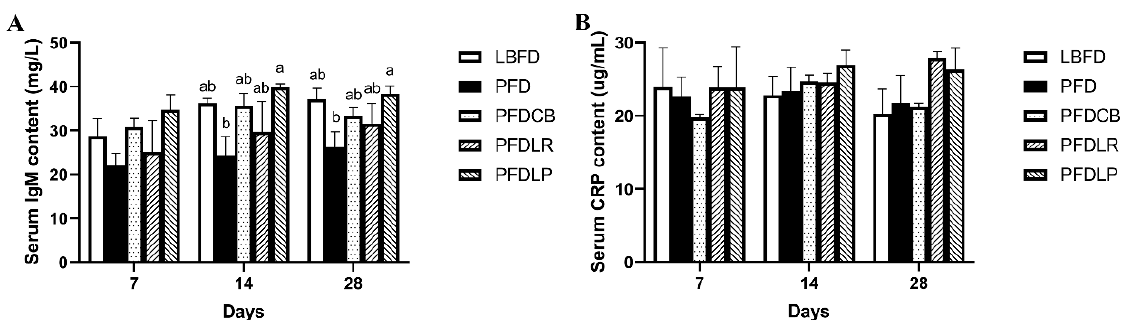
Figure 4. Serum content of IgM ( A ) and CRP ( B ) of mandarin fish in different feeding groups (LBFD, PFD, PFDCB, PFDLR and PFDLP) at day 7, 14 and 28 of feeding. Data are presented as mean ± SEM ( n = 9). Abbreviations: IgM, immunoglobulin M; CRP, C-reactive protein; LBFD, live bait fish feeding group; PFD, pellet-feed feeding group with probiotics free; PFDCB, pellet-feed feeding group with C. butyricum plus; PFDLR, pellet-feed feeding group with L. rhamnosus plus; PFDLP, pellet-feed feeding group with L. plantarum plus. A value followed by a lowercase superscript (a–b) differs significantly from all other values not followed by the same lowercase superscript at the same time point based on ANOVA followed by the post hoc test ( p < 0.05).